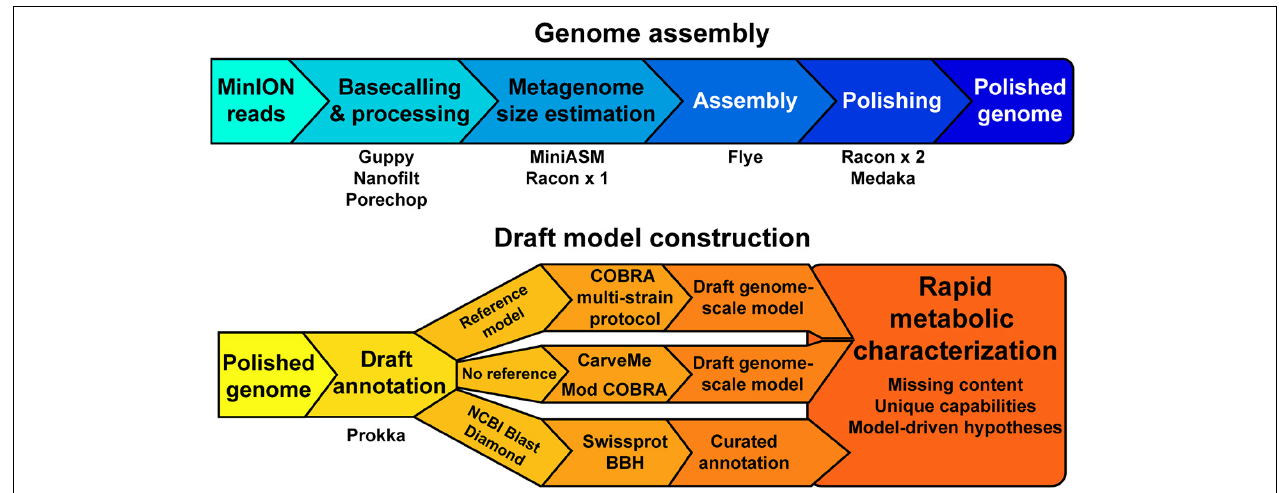
FIGURE 1 | A schematic of the genome assembly and model construction pipeline used in this study.